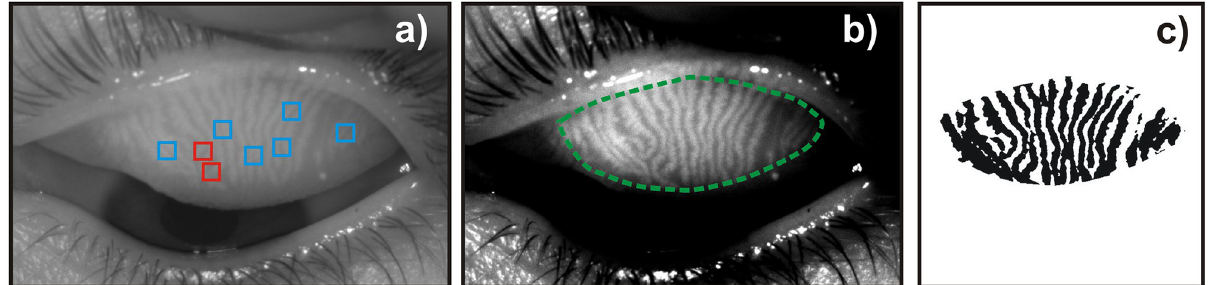
Fig 1. Pre-processing and grading of Meibomian images. a) original meibogram. Red squares show the positions where an angle of deviation exceeds 45˚. Blue squares indicate regions with noticeable narrowing of glands. b) Meibomian image with increased contrast. The green dashed line marks the area of eyelid with Meibomian glands. c) binarized Meibomian